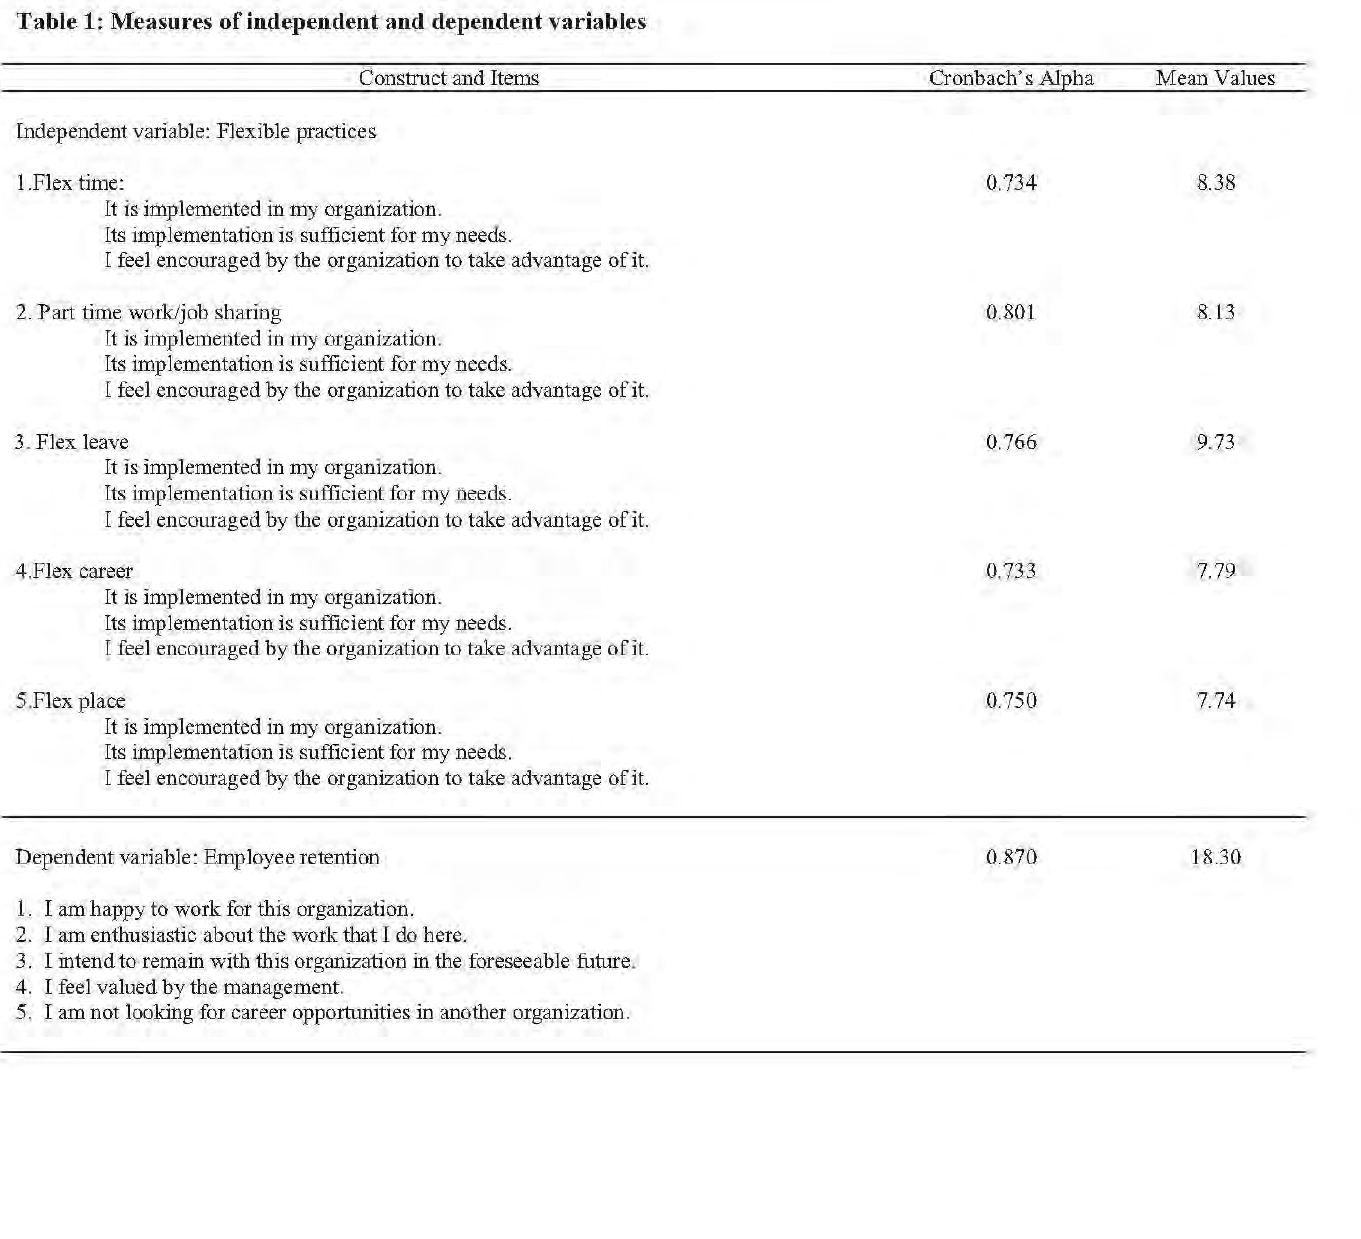
Table 1: Measures of independent and dependent variables Construct and